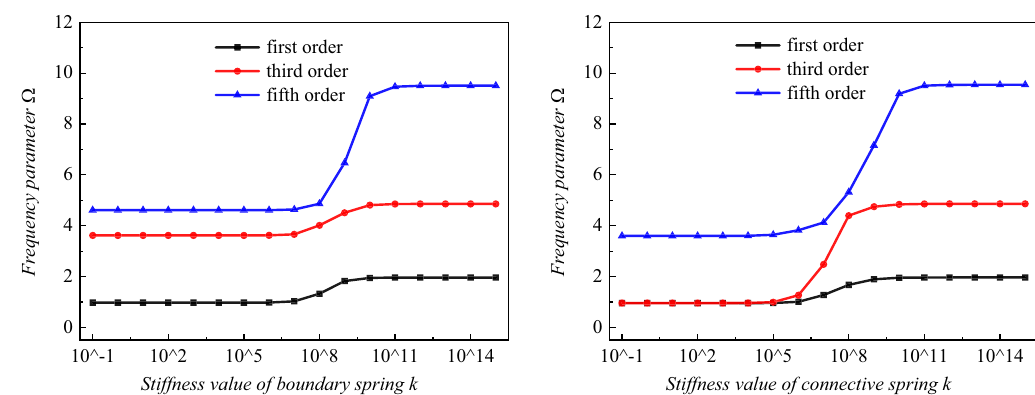
Figure 3: Frequency parameters Ω of rectangular plate with di ff erent boundary